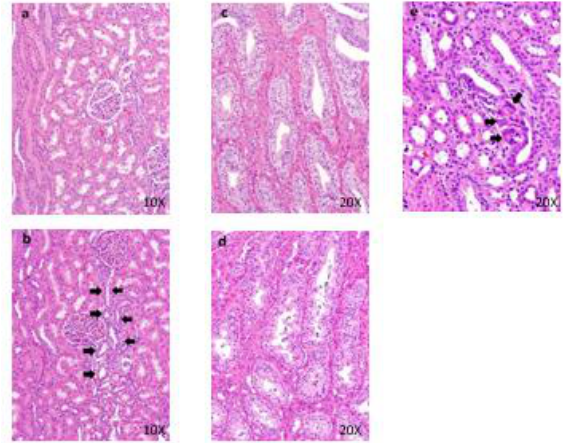
Figure 9: Histopathological findings in kidney. Control (a), 40 mg/kg (b), a , No abnormalities de- tected. b , Regeneration (arrows) of distal tubular epithelium are seen. Histopathological findings of collecting ducts in kidney. Control (c), 40 mg/kg (d), c , No abnormalities detected. d , Granular casts in collecting tubules are seen. Histopatho- logical findings in cortex in kidney. 40 mg/kg ( e ), Foreign body granuloma (arrows) in the interstit- ium are